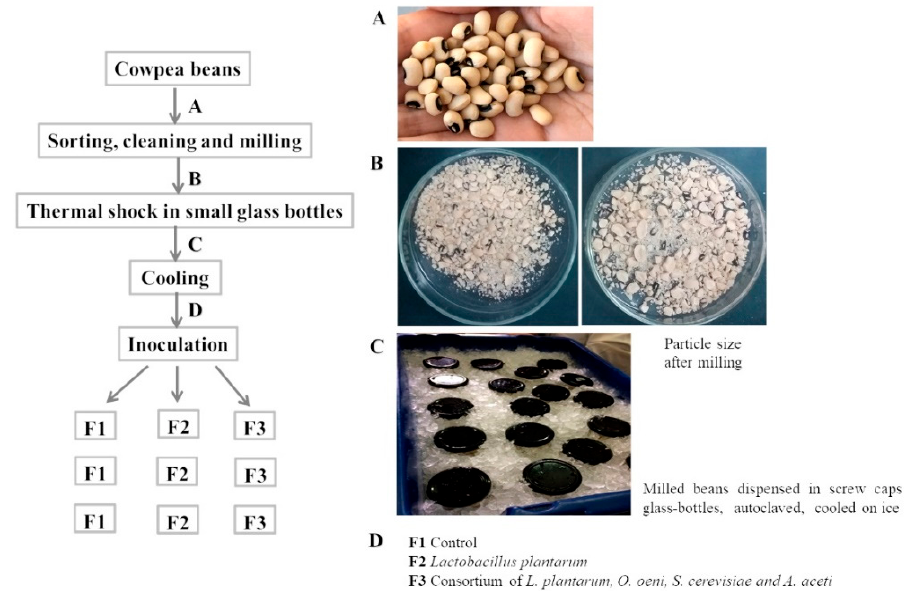
Figure 1. Flowchart showing the experimental design with the major steps of the fermented flour-bean production.